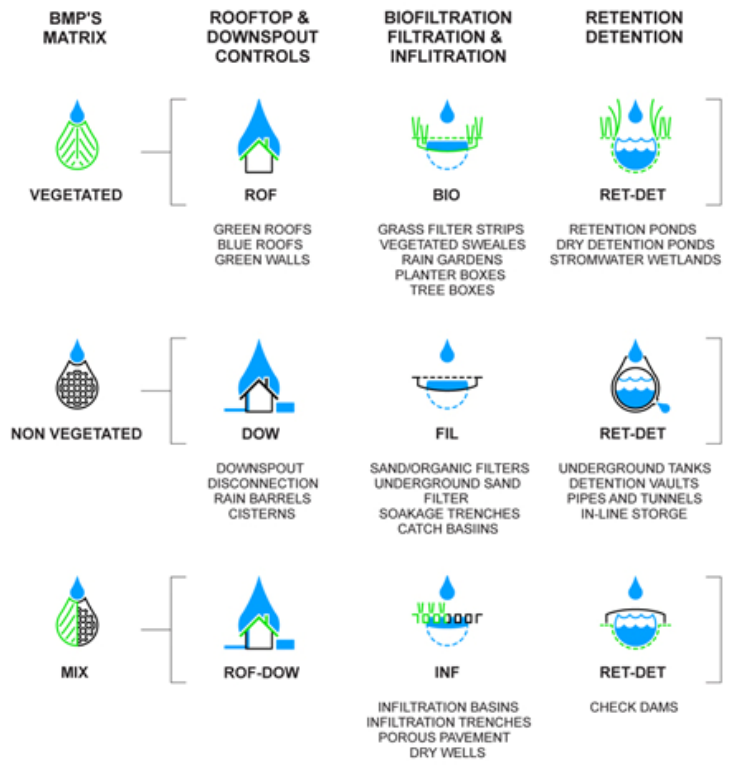
Figure 1. A matrix of best management practices for design scenarios as part of a socio-ecological feedback loop between neighborhood preferences, vegetation and water management options and nitrogen flux, Baltimore Ecosystem Biocomplexity Project, which can be applied in any urban situation across the region. (Courtesy of